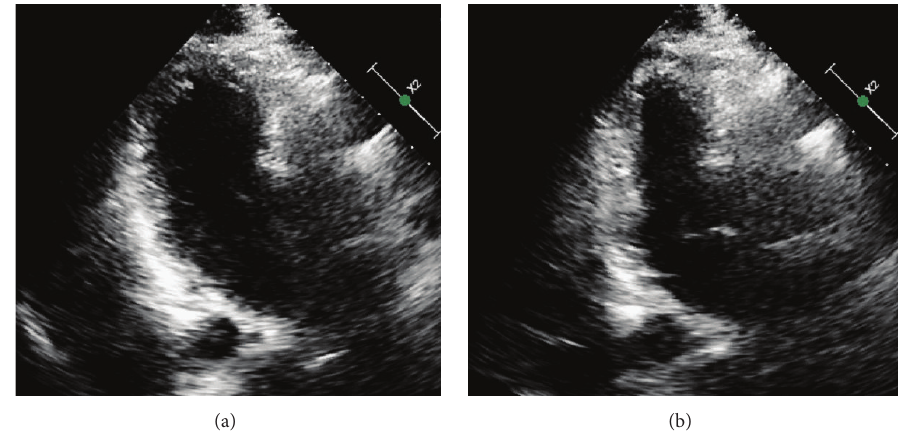
Figure 7: Echocardiographic evidence of normalization of left ventricular ejection fraction. (a) represents diastole and (b) represents